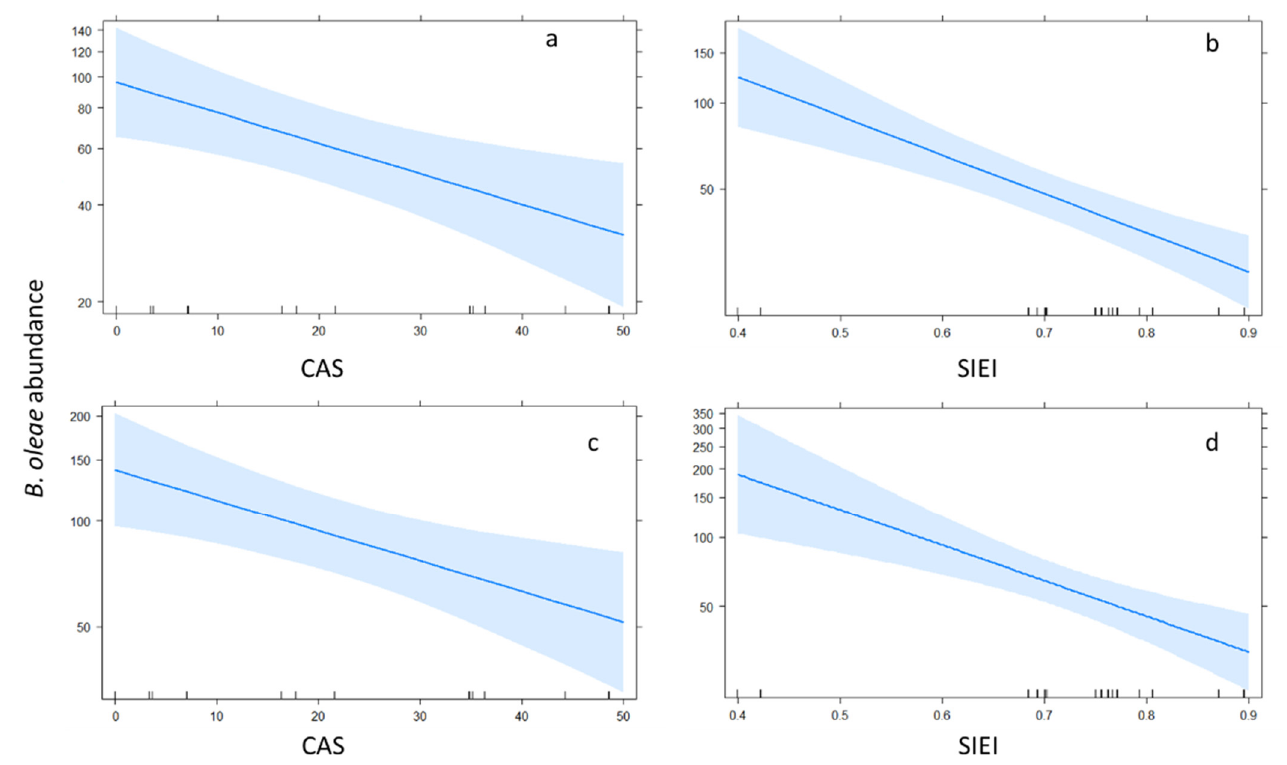
Figure 3. Effect of landscape structure on Bactrocera oleae abundance in spring 2015 ( a ), autumn 2015 ( b ), spring 2016 ( c ) and autumn 2016 ( d ). Landscape indices were scrubland area (CAS) and Simpson landscape diversity index (SIEI) calculated at 500 m buffer areas.